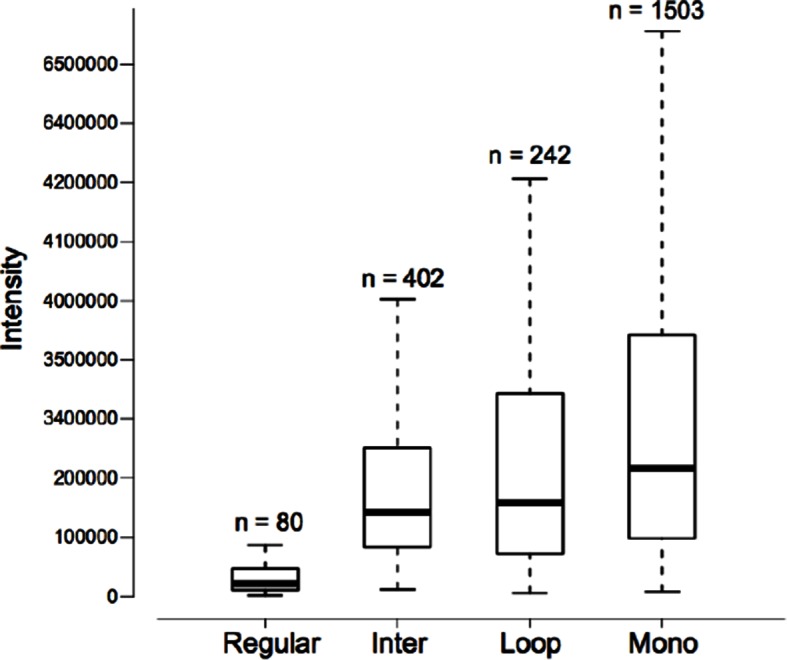
Intensity distributions of the reporter ion of m/z 122.0606 for different types of peptides.In each category, the FDR of peptide-spectrum match (PSM) is 5%. The data came from the ten standard proteins.